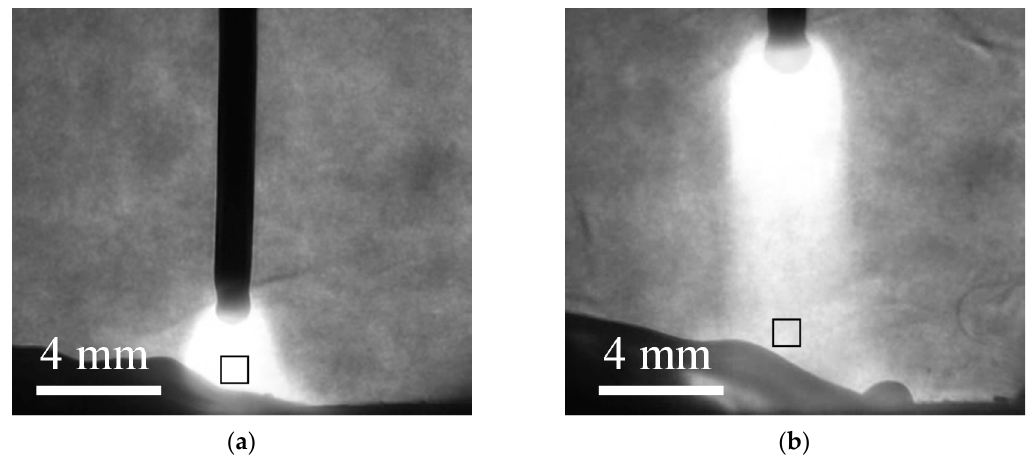
Figure 10. The gray-scale images of short and long arc morphology captured at the same peak current time: ( a ) Test 3; ( b ) Test 6.